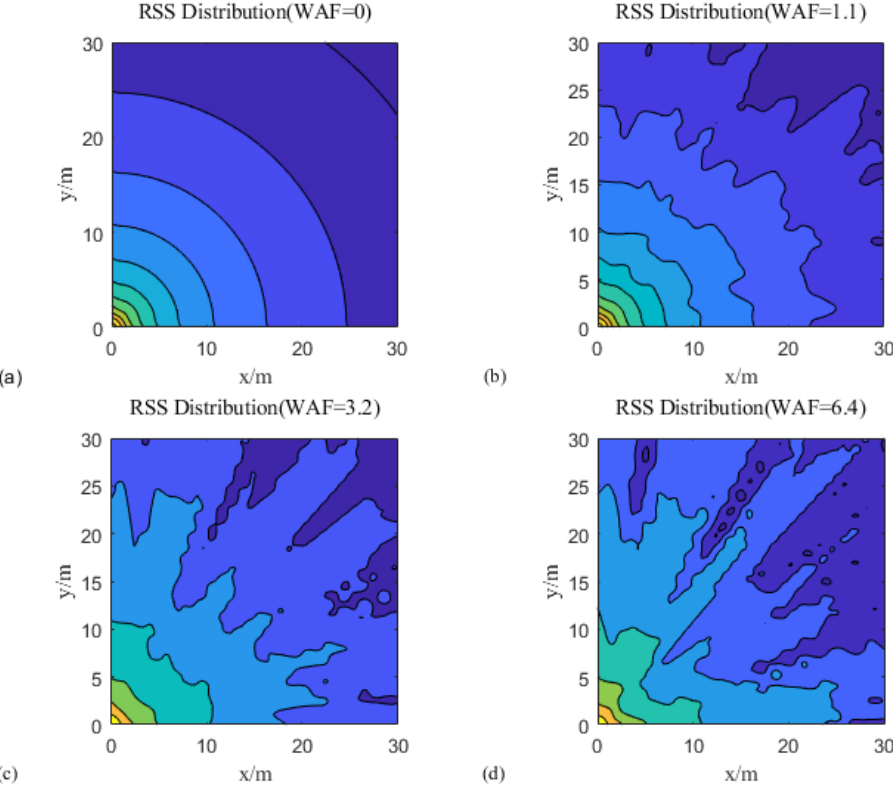
Figure 9. Received signal strength (RSS) strength mapping with wall attenuation factor (WAF) obstacles.